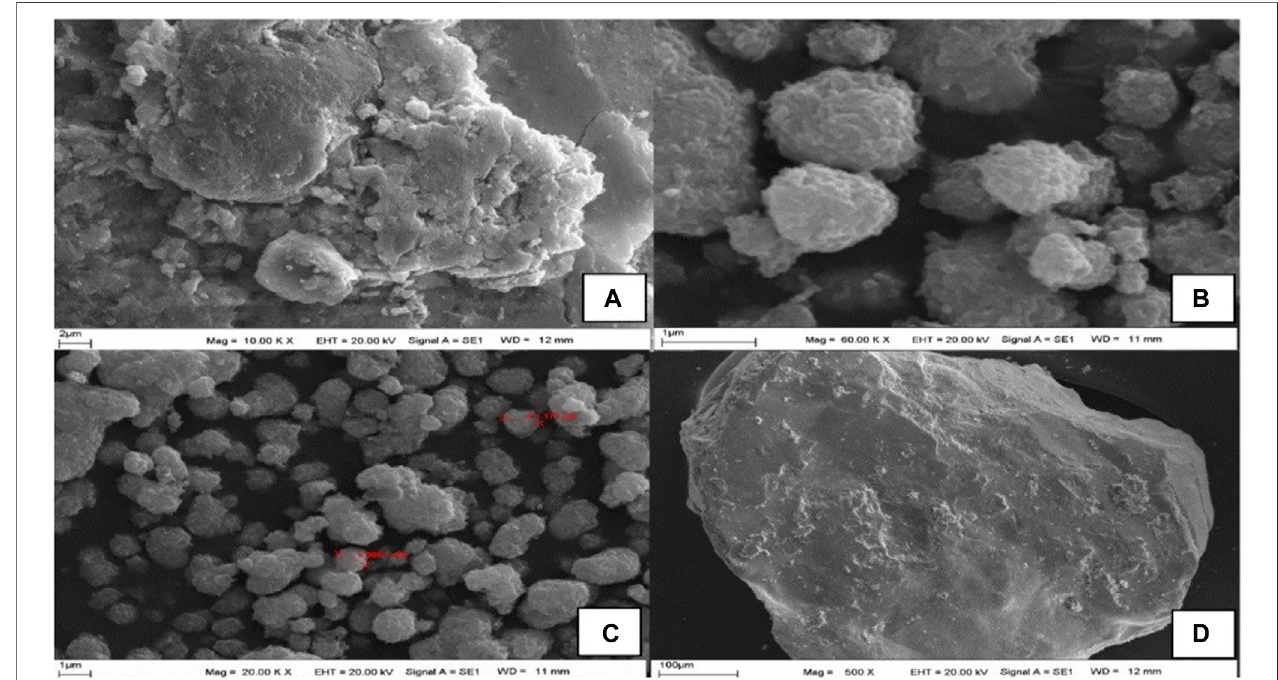
FIGURE 3 | (A – D) SEM images of CA-AgNPs in different scanning